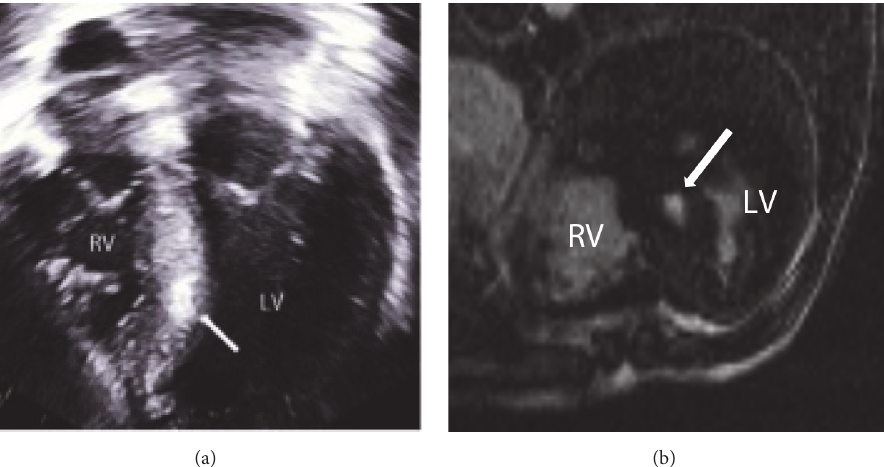
Figure 2: Sample images from echocardiography (a) and cMRI (b) performed on the same patient demonstrating positive findings (white arrows) of hyperechogenicity of the septal myocardium on echocardiography and LGE in the same location at cMRI (RV: right ventricle and LV: left ventricle).